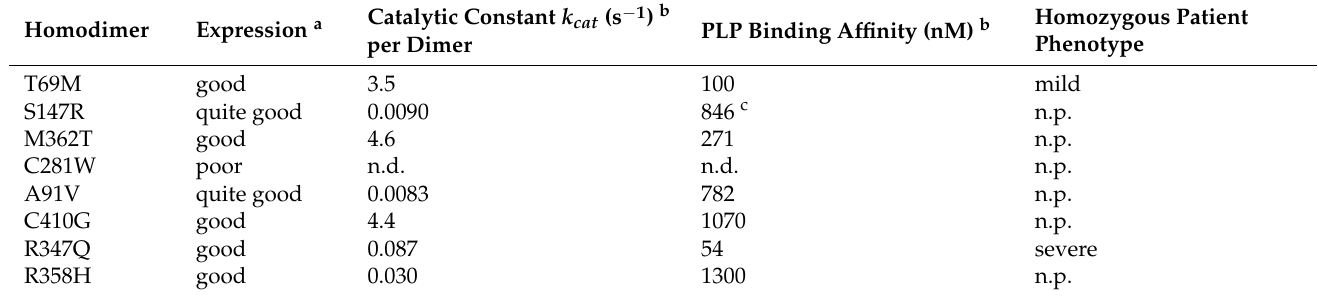
Table 2. Characteristics of the homodimeric AADC proteins present in four compound heterozygous AADC deficiency